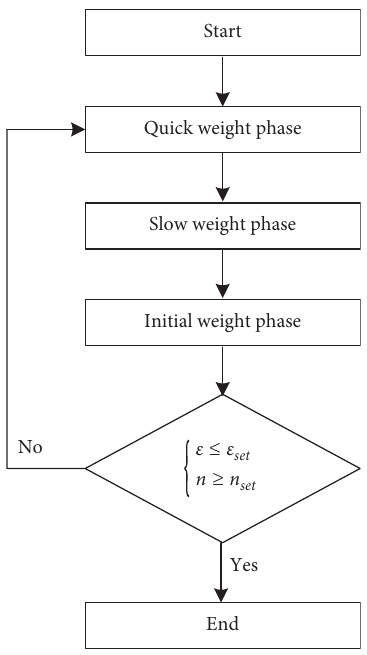
Figure 2: Optimization logic